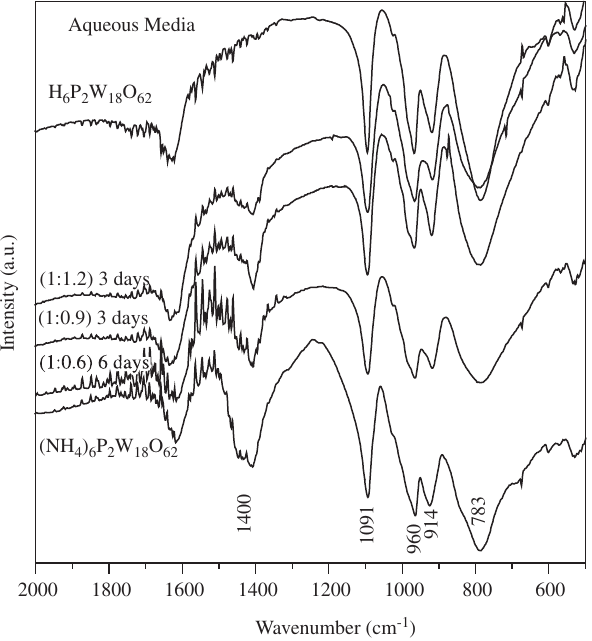
Figure 1. Infrared spectra of the (NH H P W O .24H O heteropolyacid obtained through the conventional organic 6 2 18 62 2 method and the materials obtained through the ion exchange of the salt in aque- ous media under variable (salt:resin) weight ratios and time of exchange.